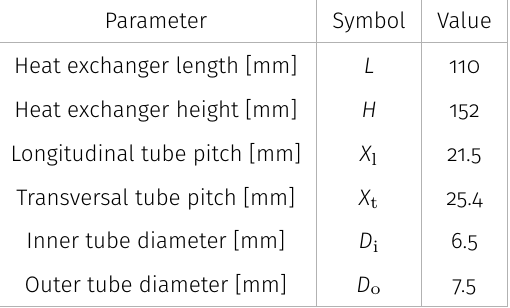
Table I. Summary of the fixed geometric parameters common to all heat exchanger